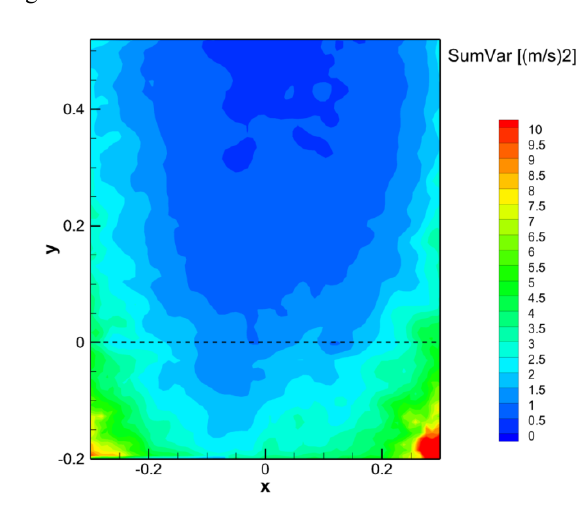
Fig. 5. Sum of velocity components variances. Re = 0.5M.